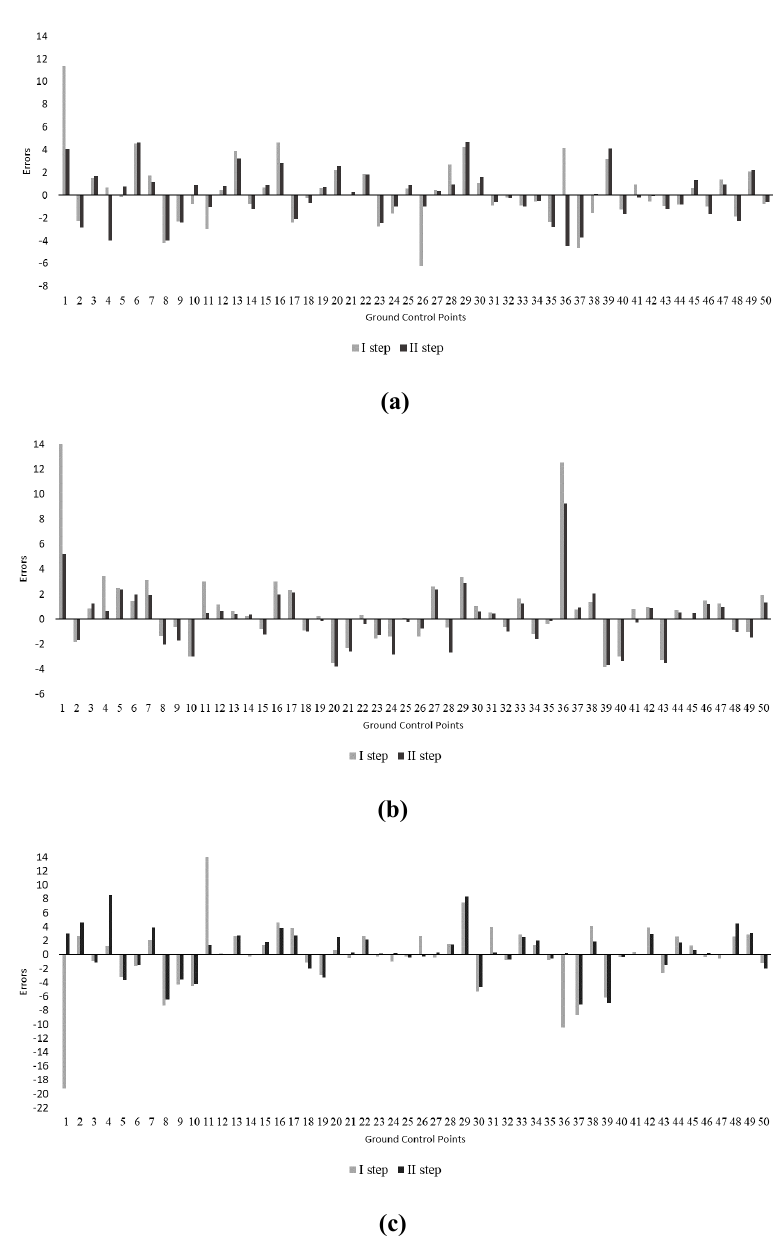
Figure 12. Bar chart comparing errors along the X ( a ), Y ( b ), and Z ( c ) directions after the first and second